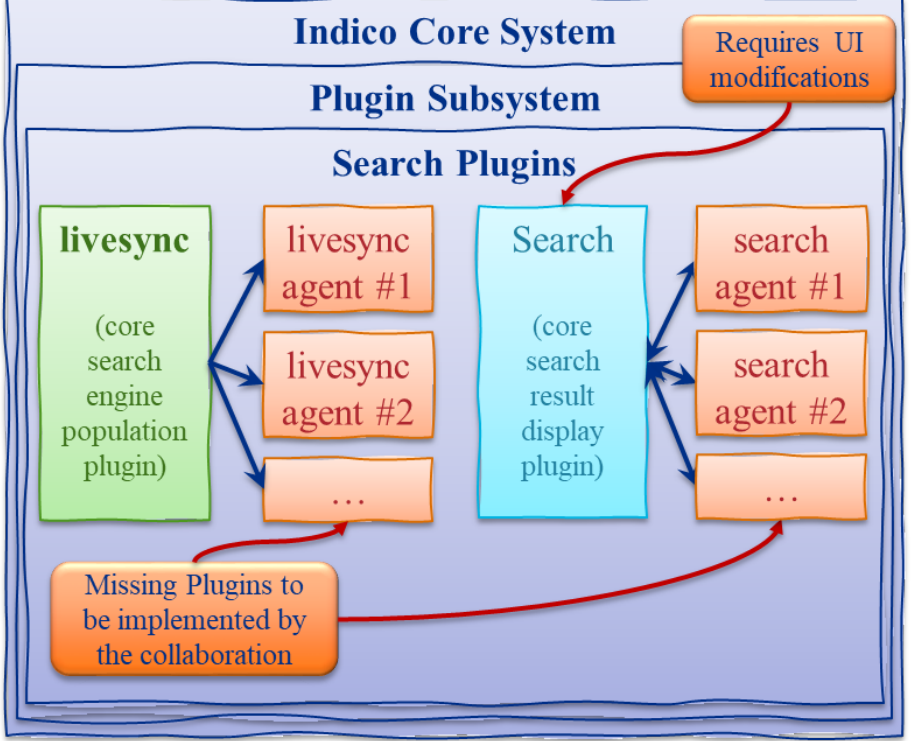
Figure 1. Indico code architecture